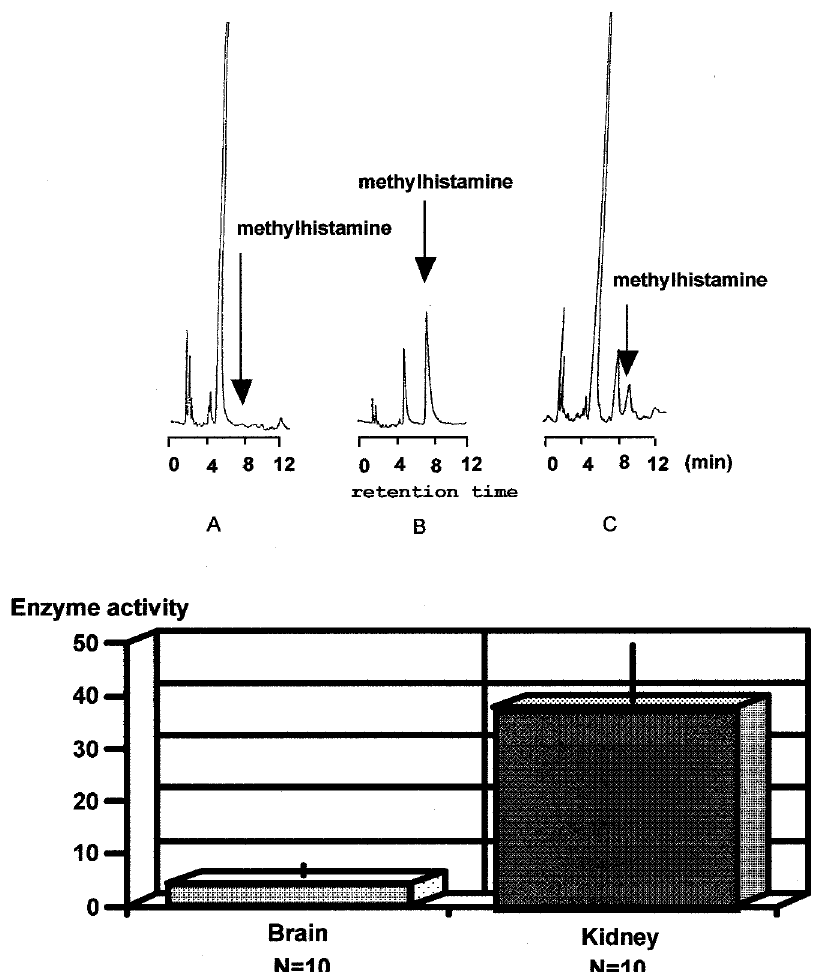
FIG. 1. Typical chromatogram of methylhistamine (upper part) and histamine- N -methyltransferase activity in rat brain and kidney (lower part). Upper part: (A) substrate blank, (B) standard of methlyhistamine, and (C) rat kidney. Lower part: enzyme activity on the vertical axis shows histamine- N -methyltransferase activity asnmol/h/mg protein. Each column represents the mean ±